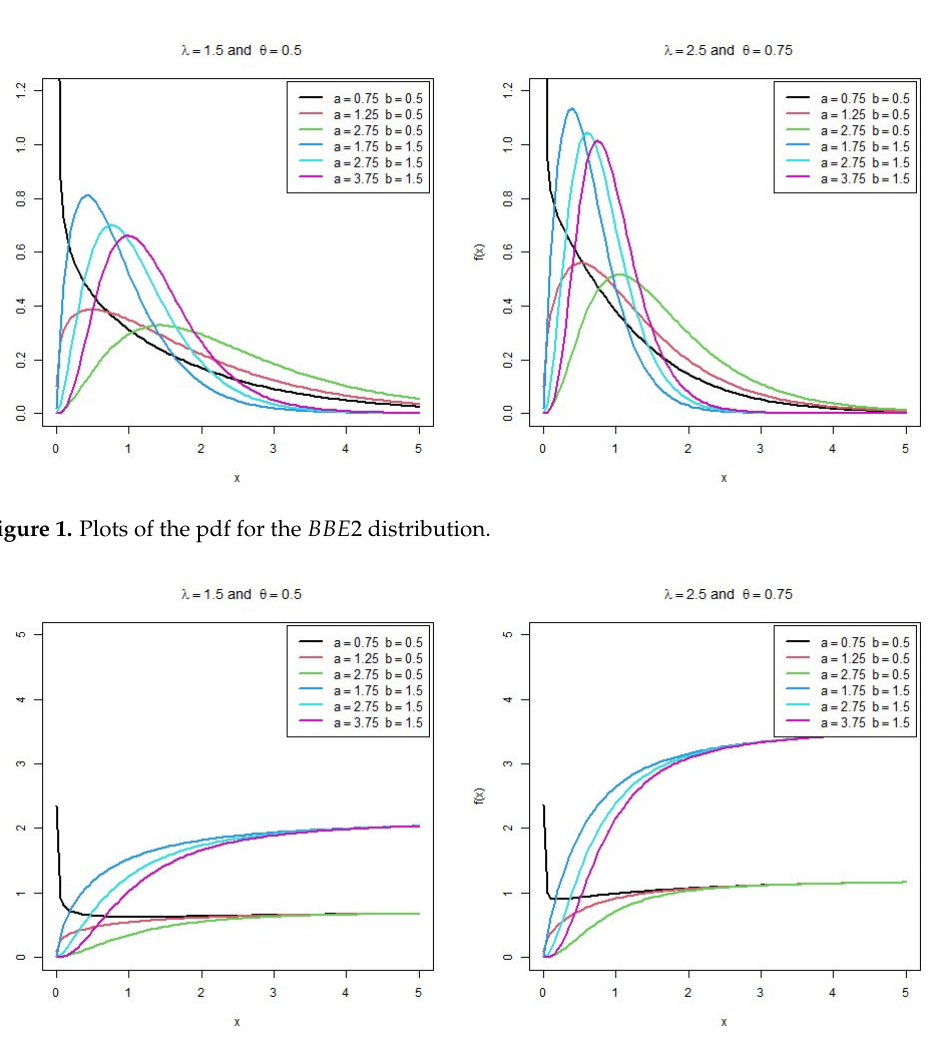
Figure 2. Plots of the hrf for the BBE 2